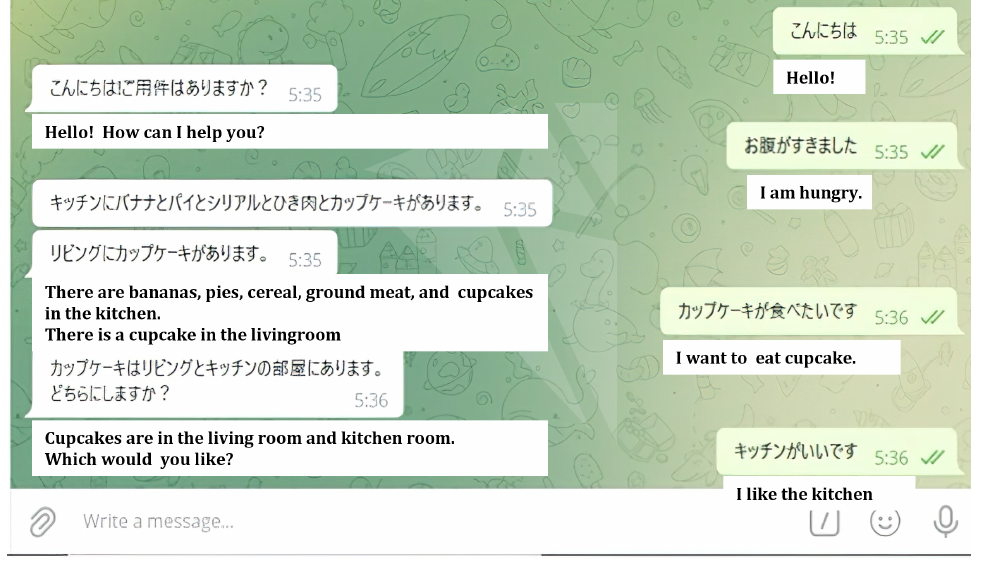
Figure 14. Example of dialogue of the proposed system.